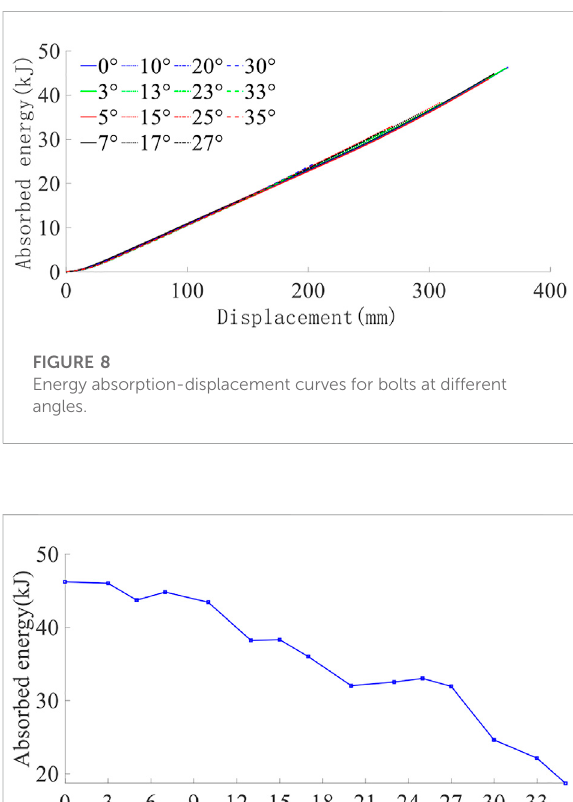
punching reaction force during the expansion stage. Figure 6, Figure 7, and Table 1 indicate that: